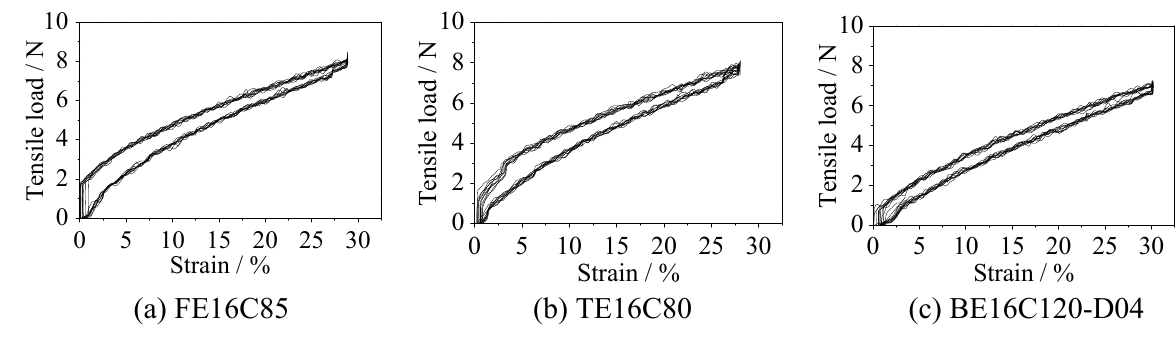
Figure 4. Typical ten stretch-recovery cycles with 30% strain of (a) flat, (b) tubular, and (c) belt webbings using sixteen elastic